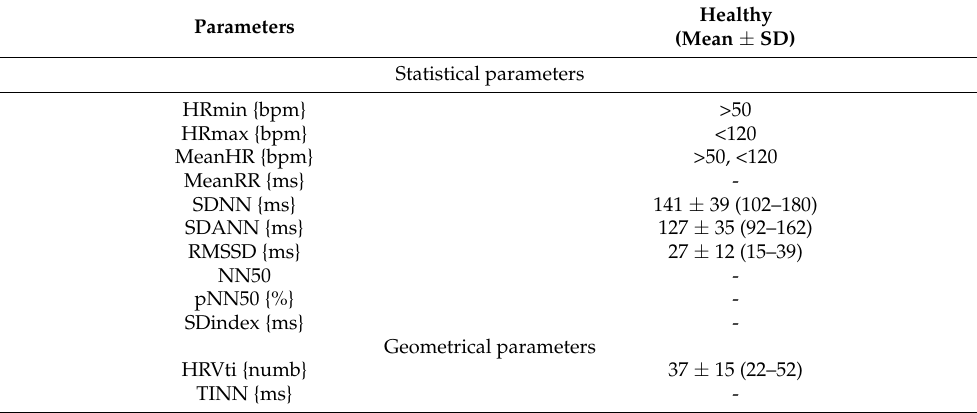
Table 1. Reference values for healthy individuals in the time domain